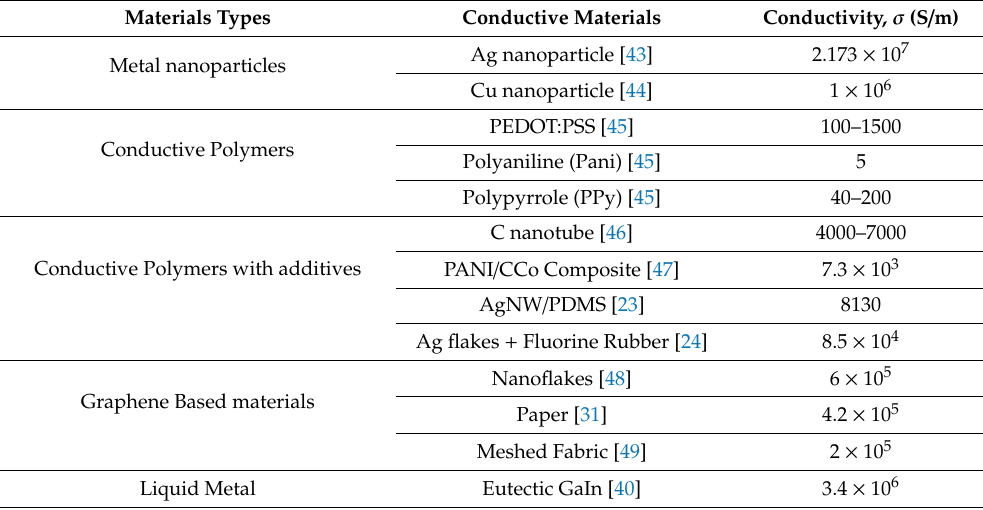
Table 1. Conductive materials and their electrical conductivity